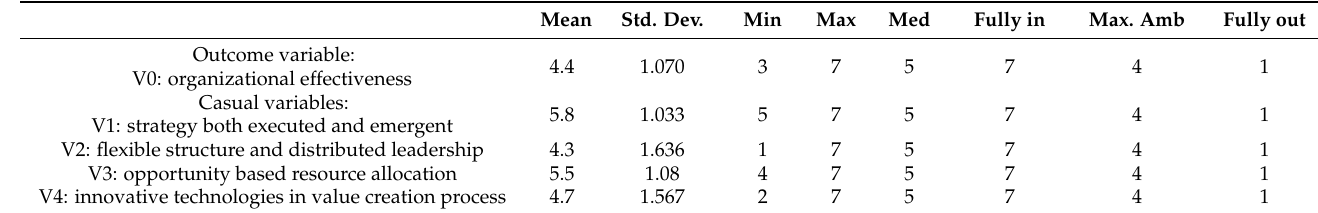
Table 5. Sample Statistics and Calibration Parameters for fsQCA. Mean Std. Dev. Max. Amb